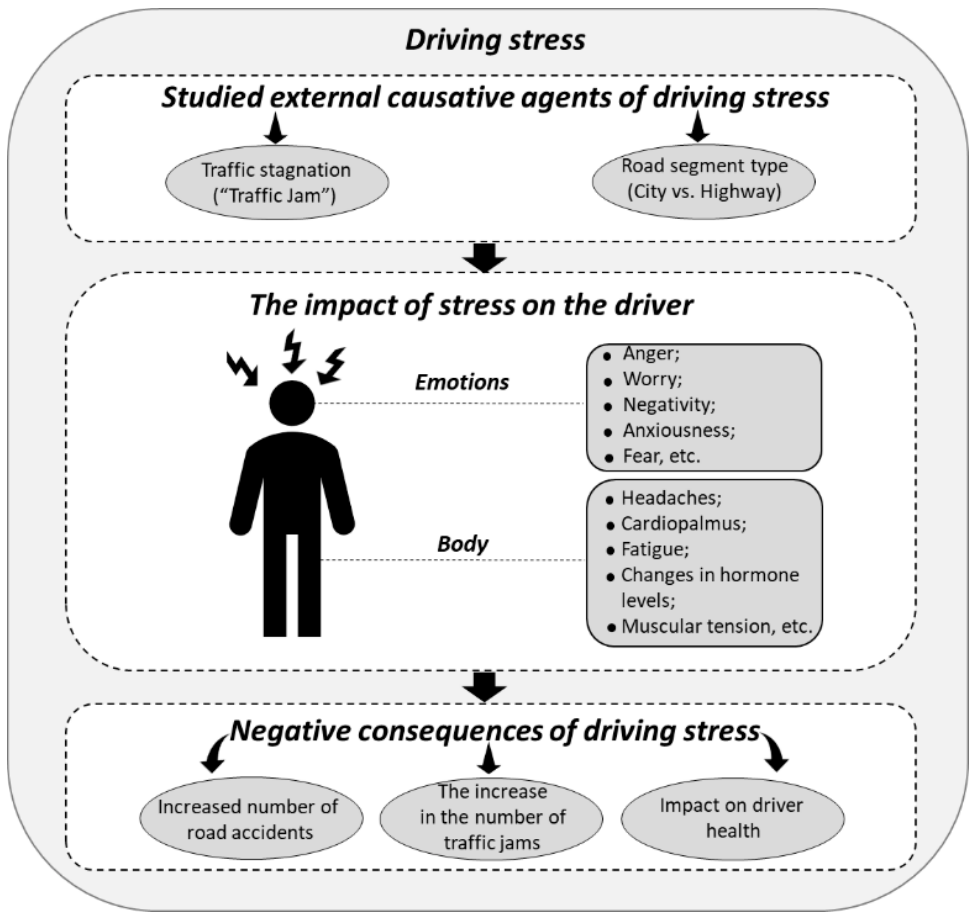
Figure 1. Relationship between driving stress and studied factors.